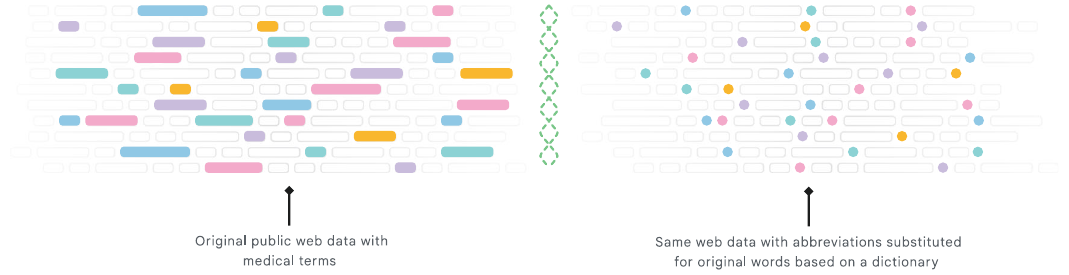
Fig.2|Overviewofweb-scalereversesubstitution. Webscalereversesubstitution